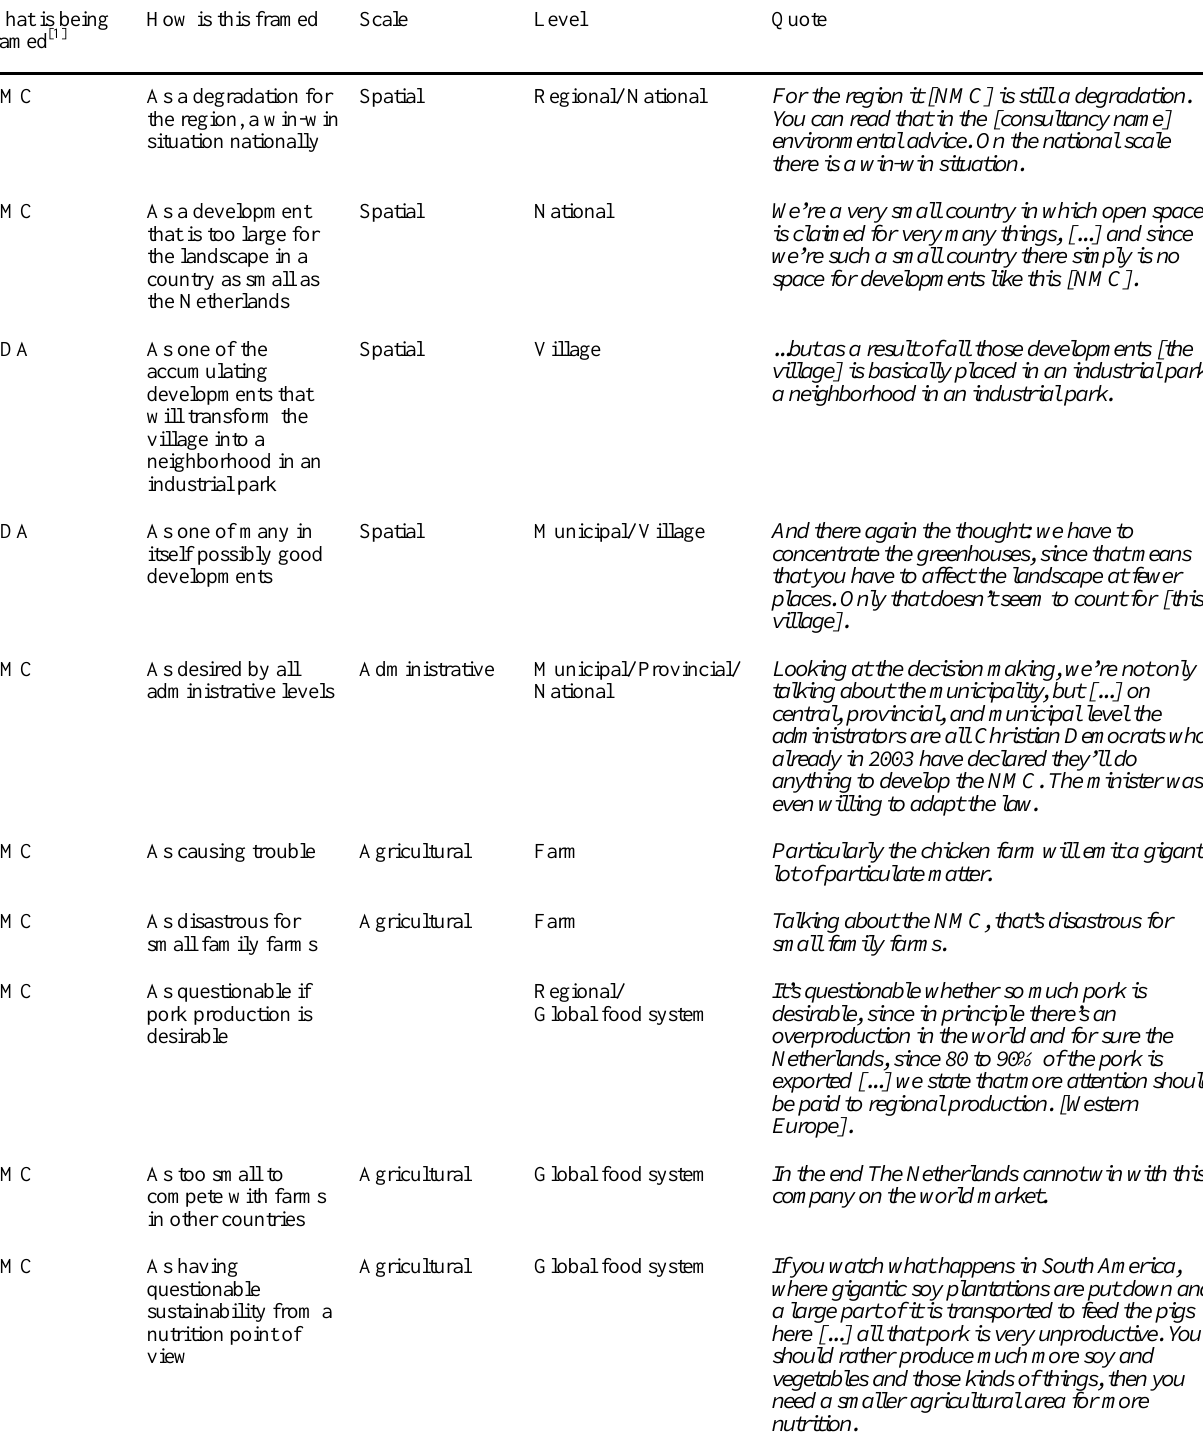
Table 3. The scales and levels used by the founder of the action group. What is being framed